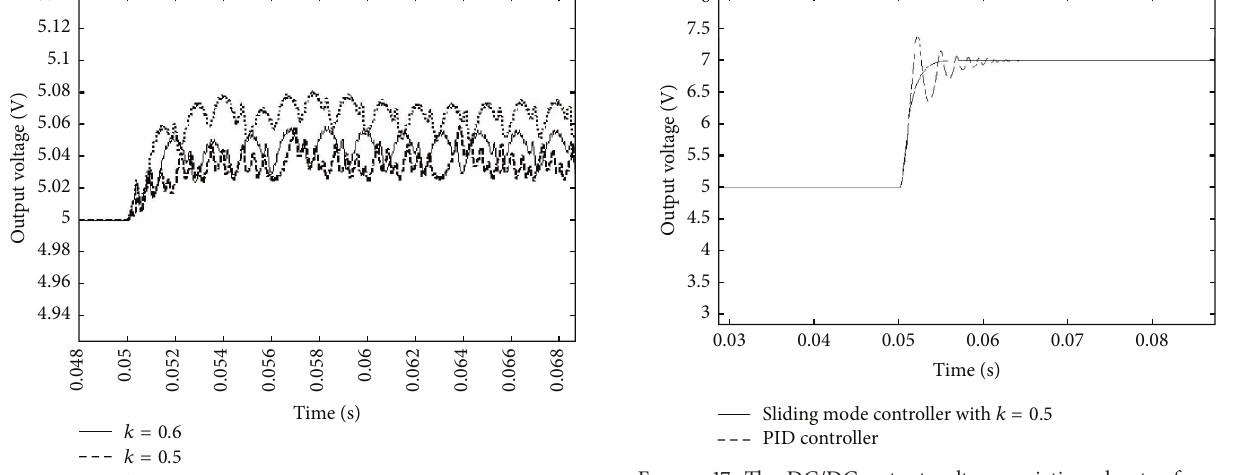
Figure 17: The DC/DC output voltage variation about reference voltage variation time.